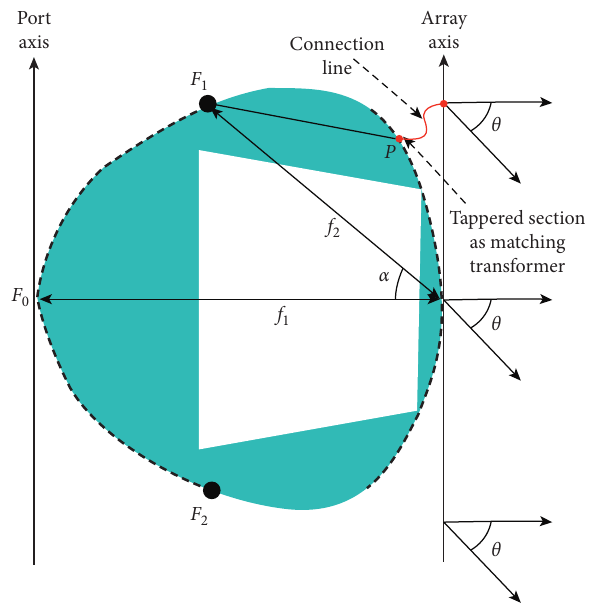
Figure 2: Rotman lens design